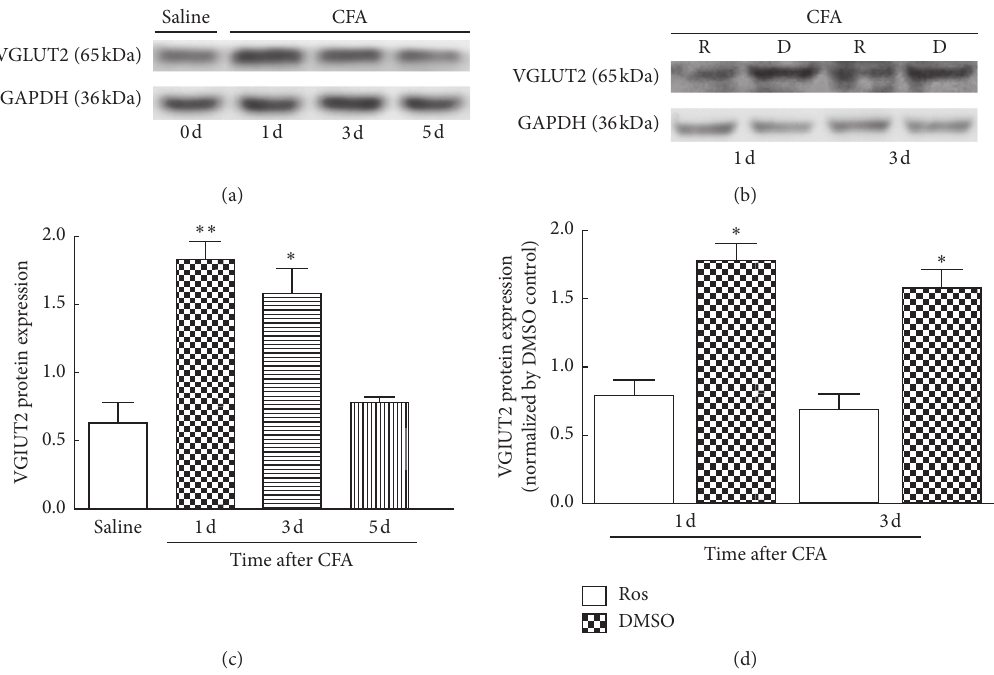
Figure 4: VGLUT2 protein expression was markedly increased in the spinal cord and reduced by roscovitine. Compared with the control group by intraplantar injection of saline, VGLUT2 expression was significantly increased from day 1 to day 3 after intraplantar injection of CFA. ∗ P < 0 . 05 and ∗∗ P < 0 . 01; n � 4/group A. Compared with the controls by intrathecal injection of DMSO, the increased expression of VGLUT2 protein was significantly reduced by intrathecal injection of roscovitine between day 1 and day 3 after intraplantar injection of CFA. Data shown represent mean ± SEM; ∗ P < 0 . 05; n � 4/group B.